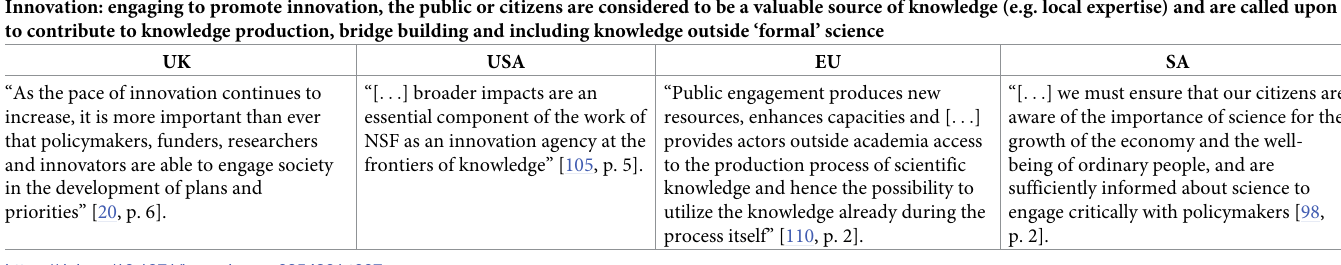
Table 7. Innovation as motivation for engagement in policy